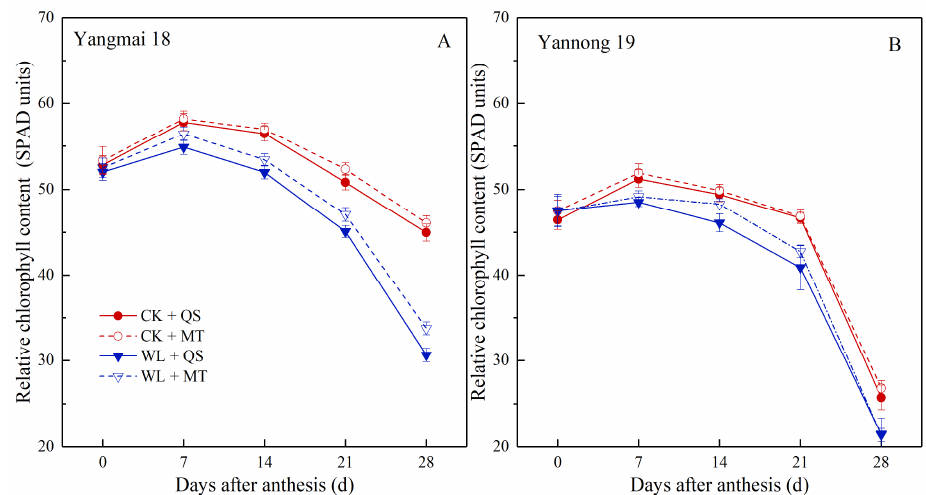
Figure 7. Post-flowering changes in flag leaf relative chlorophyll content (SPAD units) of Yangmai 18 ( A ) and Yannong 19 ( B ) under different treatments, i.e., CK + QS: leaf spraying with distilled water under non-waterlogged conditions; CK + MT: leaf spraying with 100 μmol·L −1 of melatonin under non-waterlogged conditions; WL + QS: leaf spraying with distilled water under waterlogged conditions; WL + MT: leaf spraying with 100 μmol·L −1 of melatonin under waterlogged conditions.